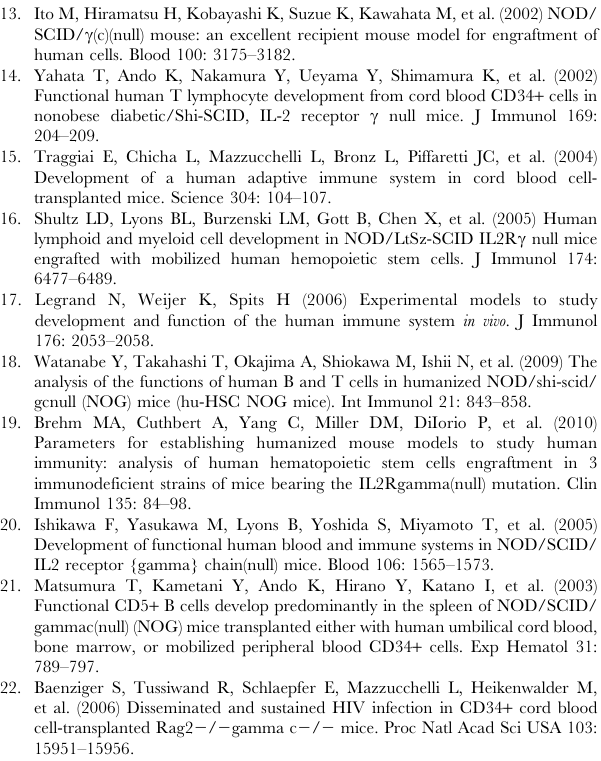
Table S1 Human reconstitution in blood of DRAG and control mice upon infusion of HLA-DR*0401 hemato- poietic stem cells. (*) human cell frequencies measured at 25 weeks post-infusion of HSC. ( # ) concentration of plasma levels of human IgM and IgG (32 weeks post-infusion of HSC) and IgA and IgE (25 weeks post-infusion of HSC). ( & ) mice were immunized with TT at week 31 post-infusion of HSC. (ND) not